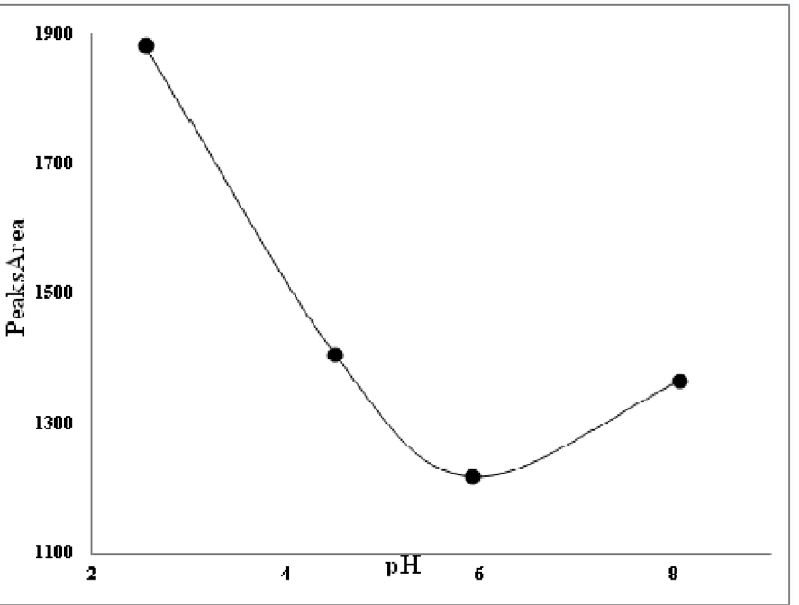
Figure 4. Variation of total phenolic compounds versus extracting solution pH for selection of optimum pH.